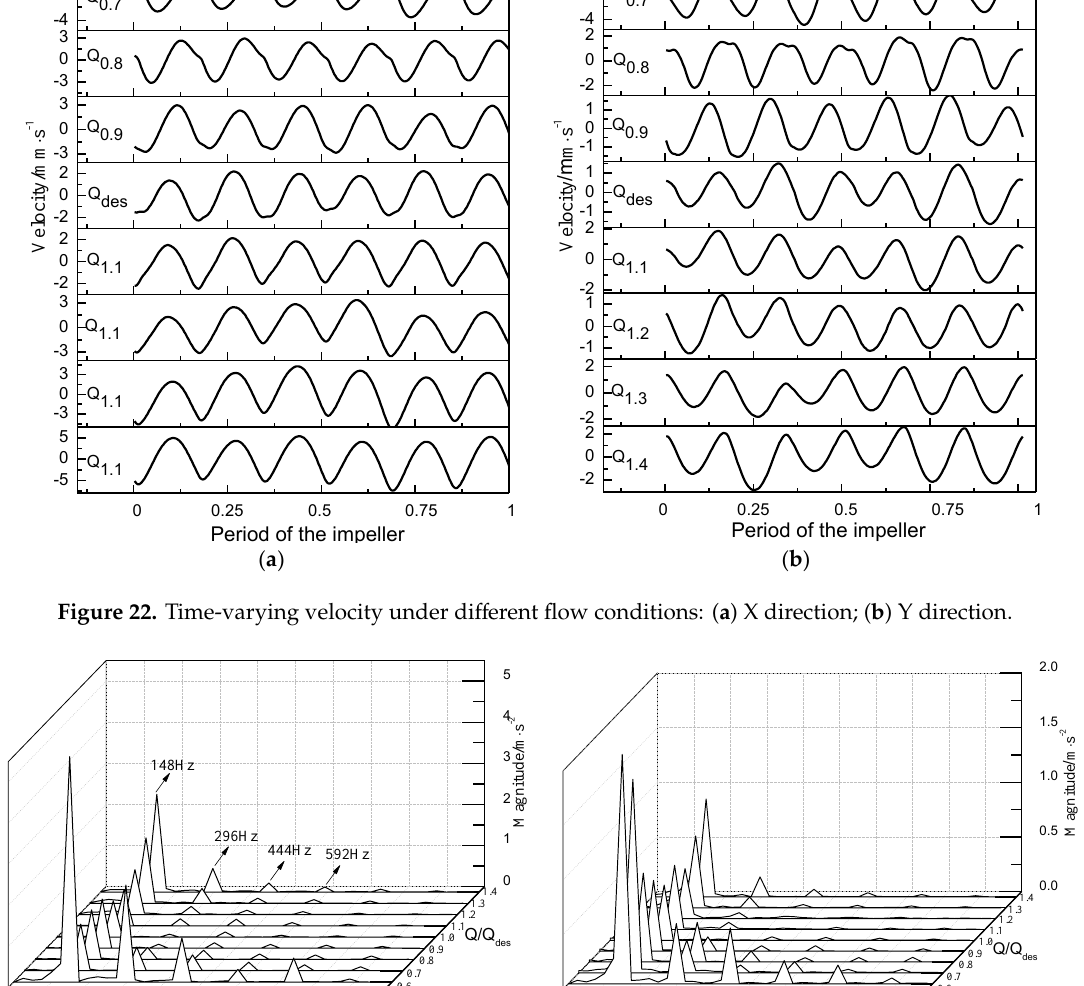
Figure 24. Frequency distribution of the velocity under different flow conditions: ( a ) X direction; ( b ) Y direction.